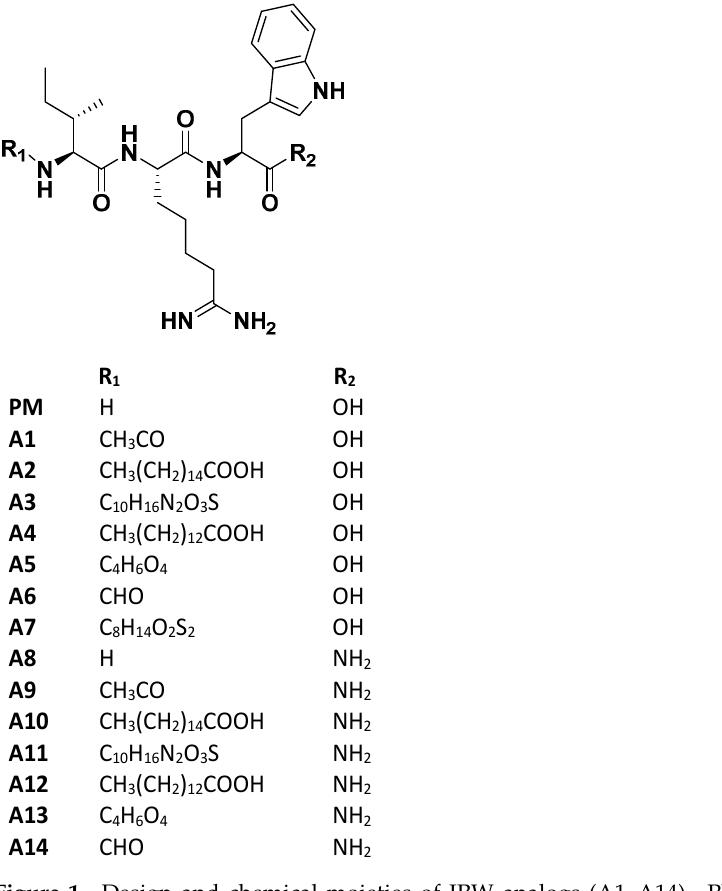
Figure 1. Design and chemical moieties of IRW analogs (A1–A14). PM: NH 2 -IRW-COOH A1: Acet- ylation-IRW-COOH; A2: Palmitic Acid-IRW-COOH; A3: Biotin-IRW-COOH; A4: Myristoyl-IRW- COOH; A5: Succinylation-IRW-COOH; A6: Formylation-IRW-COOH; A7: Lipoic acid-IRW-Amide; A8: NH 2 -IRW-Amide; A9: Acetylation-IRW-Amide; A10: Palmitic Acid-IRW-Amide; A11: Biotin- IRW-Amide; A12: Myristoyl-IRW- Amide; A13: Succinylation-IRW-Amide; A14: Formylation IRW- Amide. PM: Parent molecule; A1–A14: Analog1-Analog14.